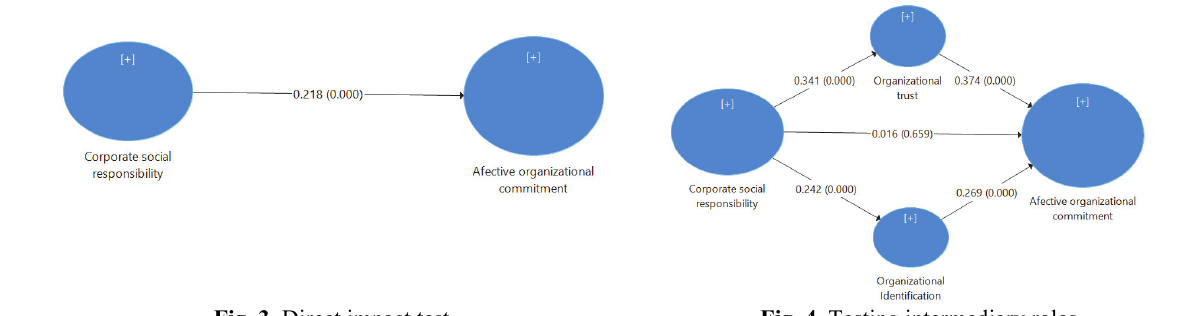
Original Sample Standard Sample (O) Mean (M) Deviation (STDEV)